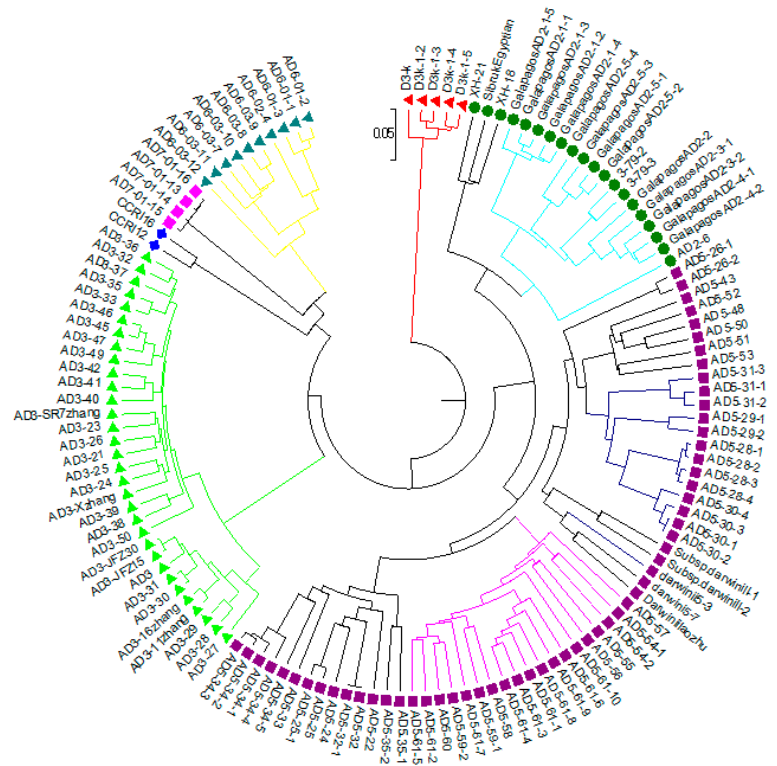
Figure 5. Dendrogram of 132 wild cotton accessions by Unweighted Pair-Group Method using Arithmetic average (UPGMA) analysis. Colors in the dendrogram lines correspond to Gossypium accession populations as identified by structure analysis while the colors in the circle represent the seven species. A membership threshold of 70% was used to assign accessions to different clusters in this dendrogram based on structure analysis.